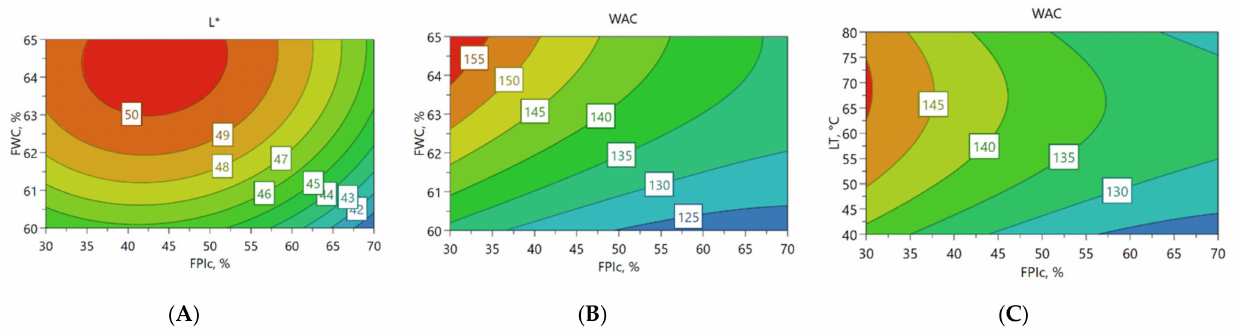
Figure 3. Contour plots from the MLR model showing the effect of feed water content (FWC) and faba bean protein isolate content (FPIc) on lightness (L*) ( A ) and on the water absorption capacity (WAC) ( B ) when the LT was 60 ◦ C, and the effect of the long cooling die temperature (LT) and FPIc on the WAC ( C ) when FWC was